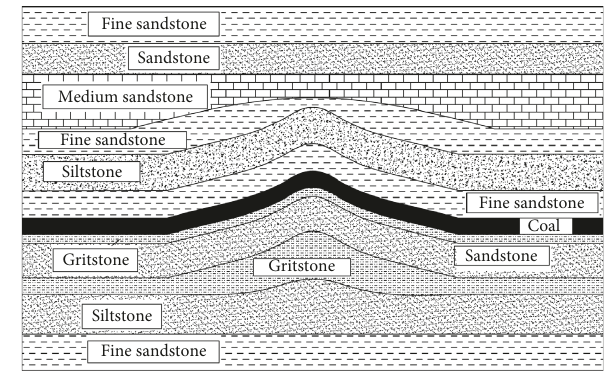
Figure 7: Simplified graphic numerical